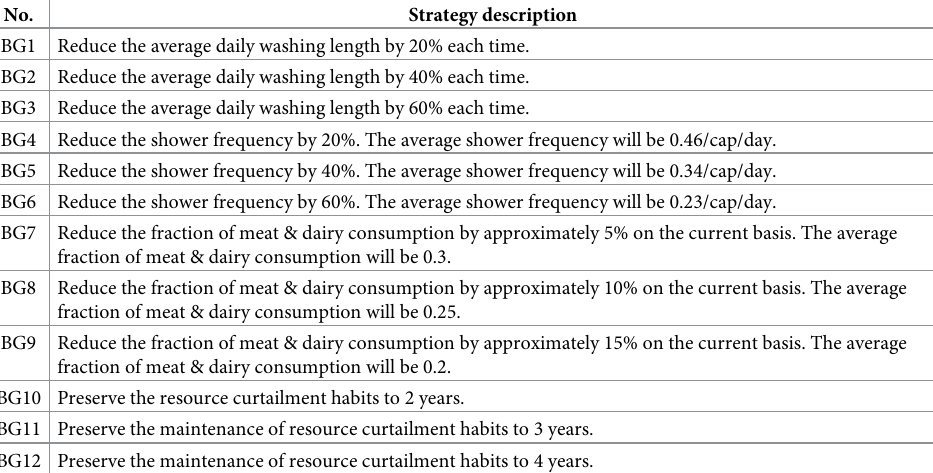
Table 3. Overview of FEW conservation strategies—specific behavioural guidance & household enhancement measures (BG). No. Strategy